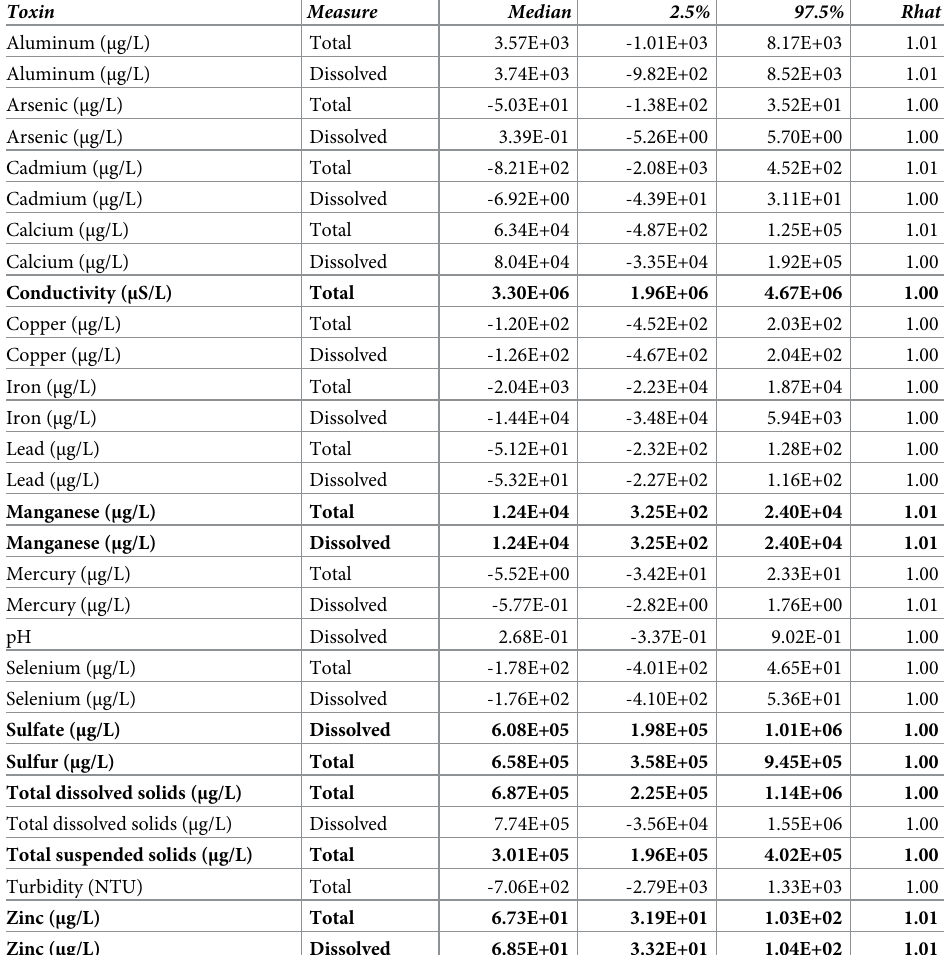
Table 2. Significant positive relationships were estimated between mined area and nine measures of water